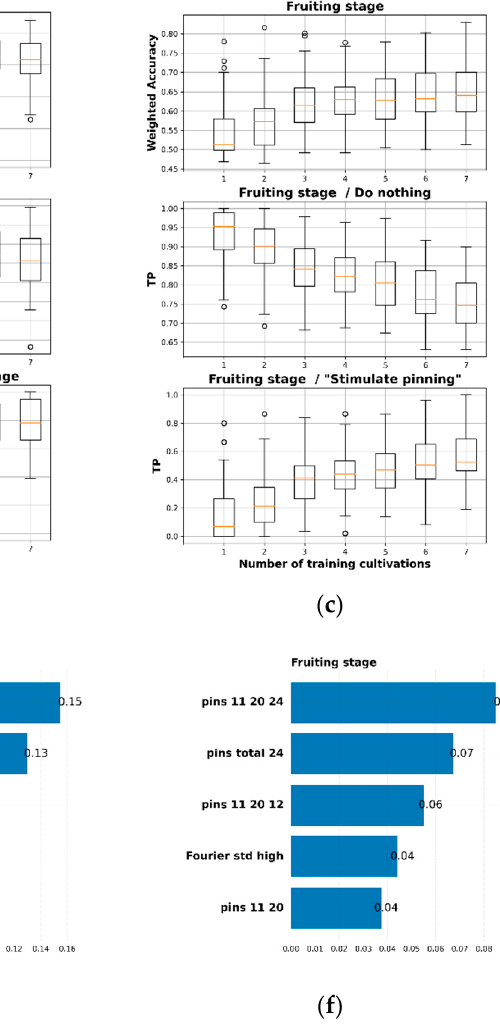
Figure 15. Boxplots of experimental distribution of weighted accuracy and true positive (TP) rates for each class of the decision-making models in incubation stage ( a ), shock stage ( b ), and fruiting stage ( c ), and averaged importance of variables in training with 11 cultivations for incubation ( d ), shock ( e ), and fruiting ( f ) stages.